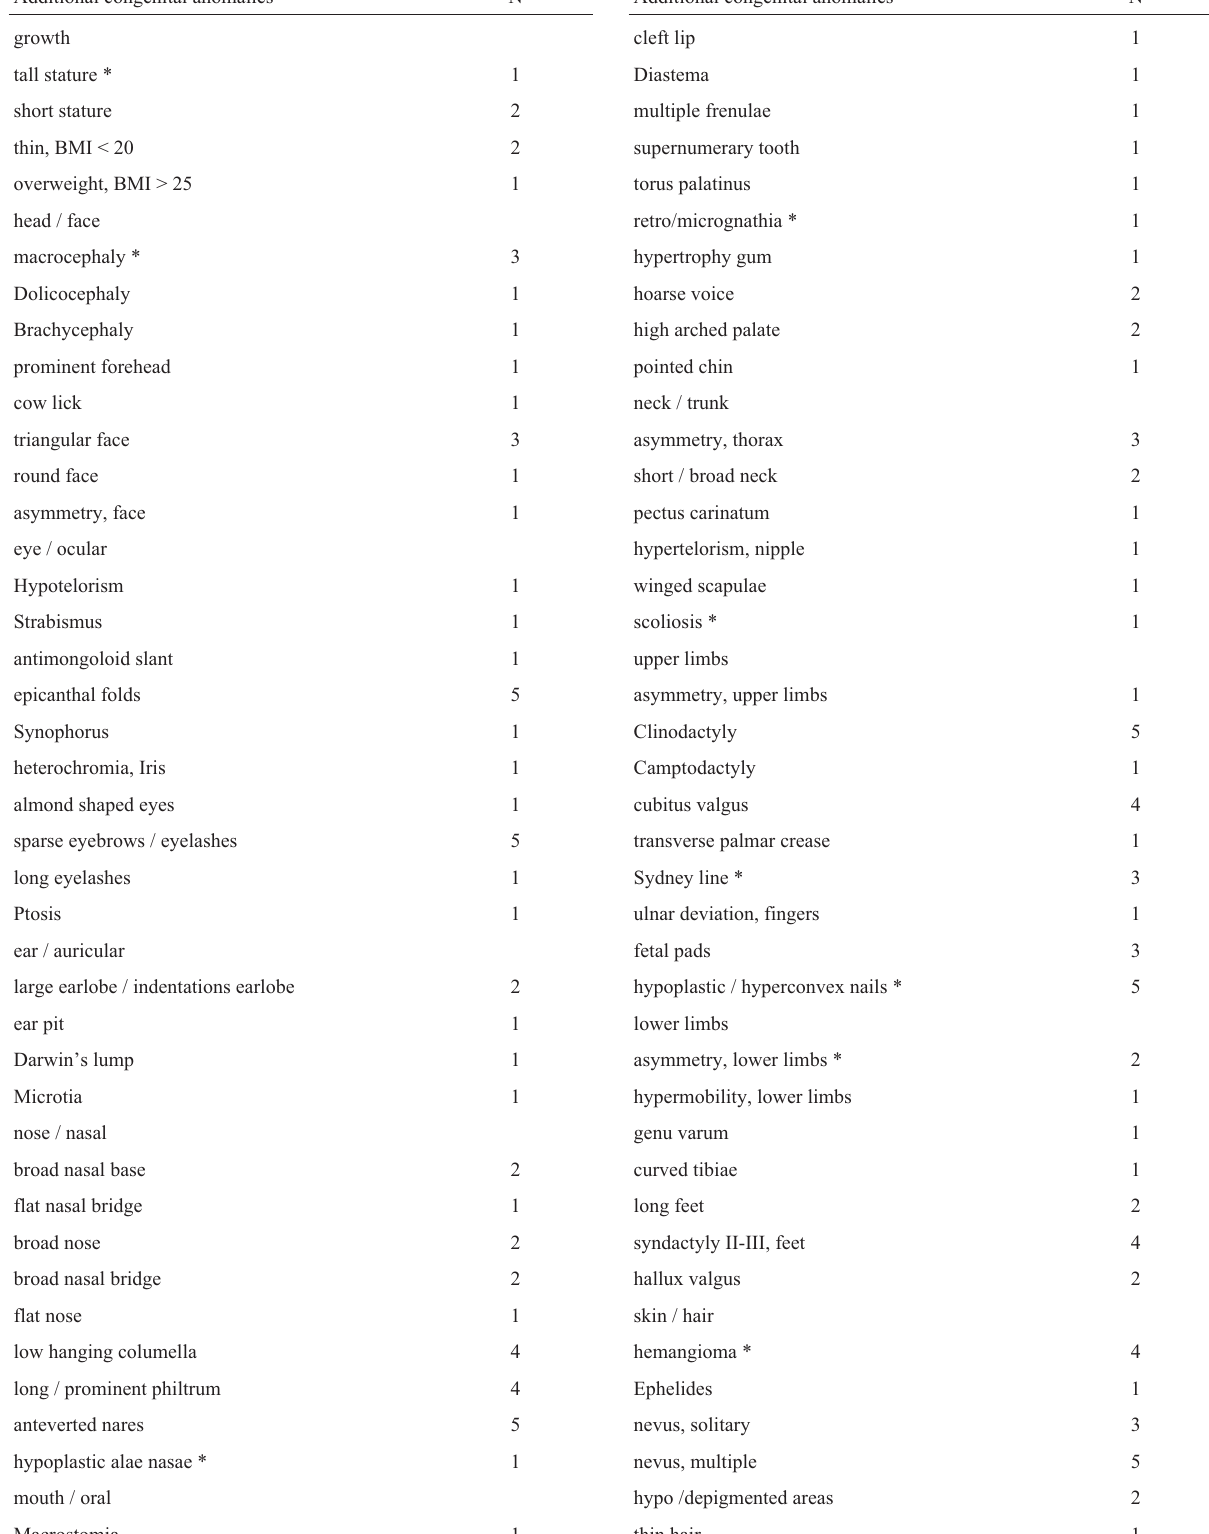
Table 3 - Birth defects, congenital anomalies, and morphologic variants observed in children with pediatric solid tumor and multiple CALMs. Variants marked with an asterisk (*) have been previously associated with pediatric cancer (Merks et al. , 2008). Additional congenital anomalies